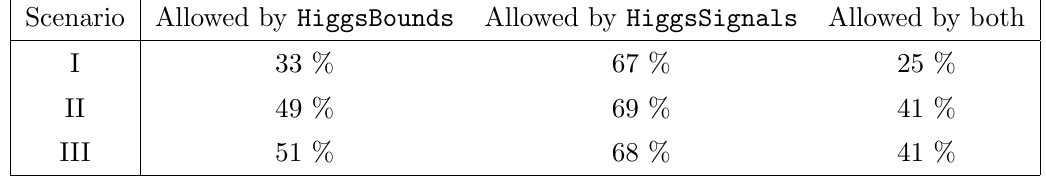
How many parameter points that pass the constraints from HiggsBounds and HiggsSignals in scenario I to III.